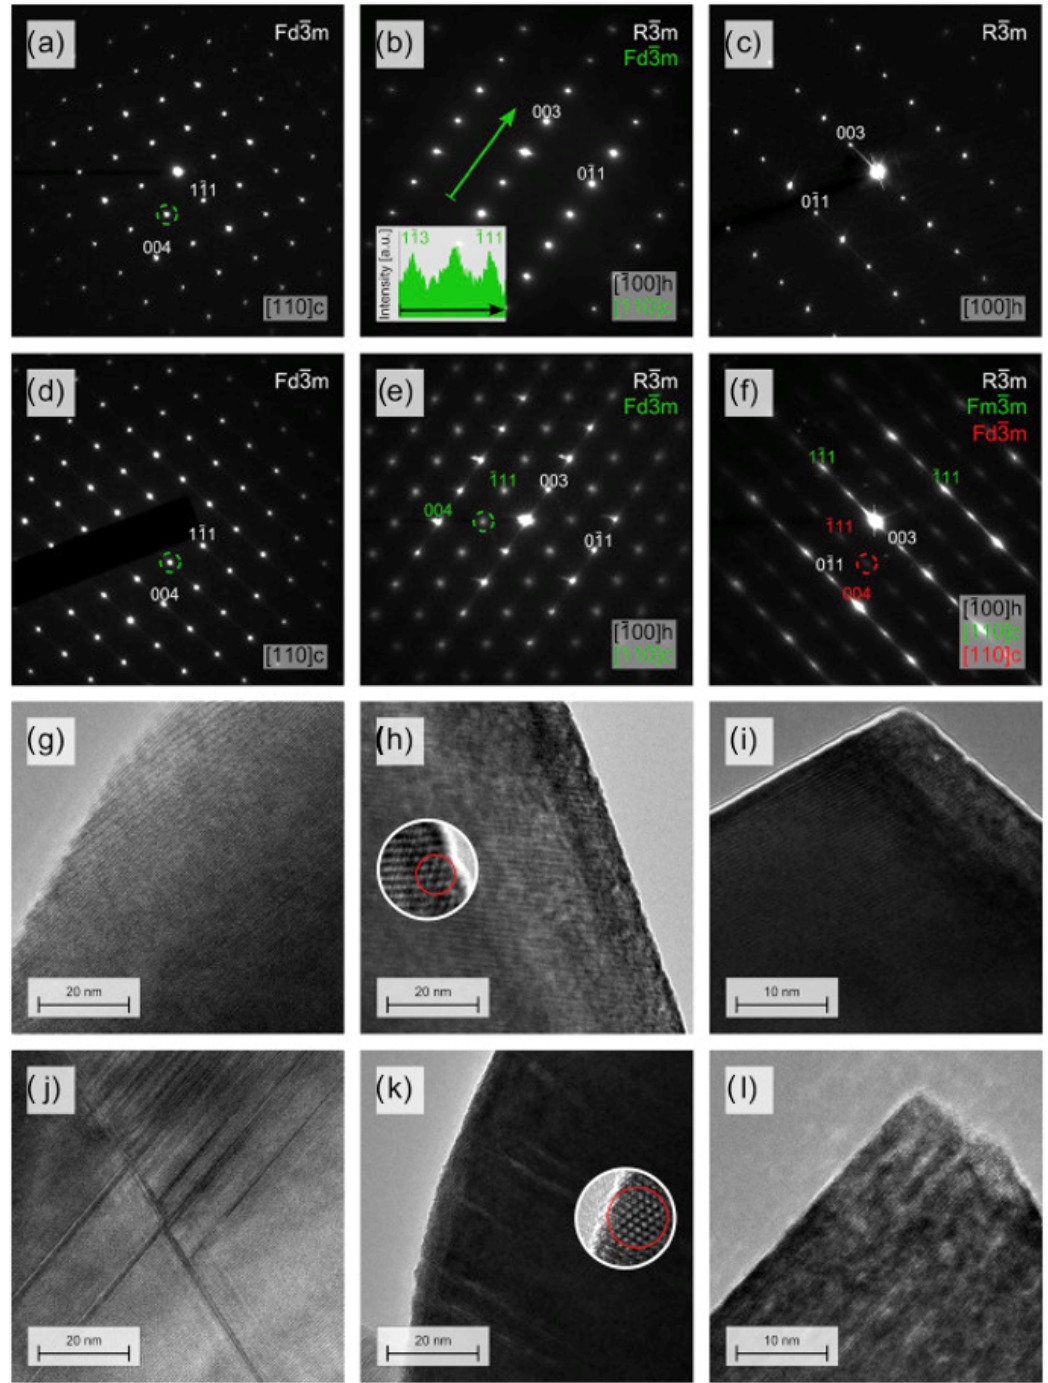
Figure 11. Diffraction pattern from changing materials of BOL cathodes: ( a ) LMO; ( b ) LiNi 0.5 Co 0.2 Mn 0.3 O 2 (NCM); ( c ) LiNi 0.8 Co 0.15 Al 0.05 O 2 (NCA). Diffraction patterns from cathode which were aging using high rates at 40 ℃ (HR40): ( d ) LMO; ( e ) NCM; ( f ) NCA. HRTEM images: ( g ) LMO; ( h ) NCM; ( i ) NCA and under HR40 condition: ( j ) LMO; ( k ) NCM; ( l ) NCA [66]. Reprint with permission [66]; Copyright 2016, Elsevier.